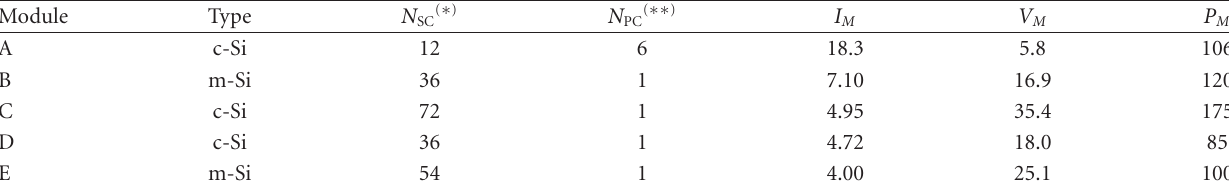
Table 4: Parameters at standard test conditions of di ff erent modules.